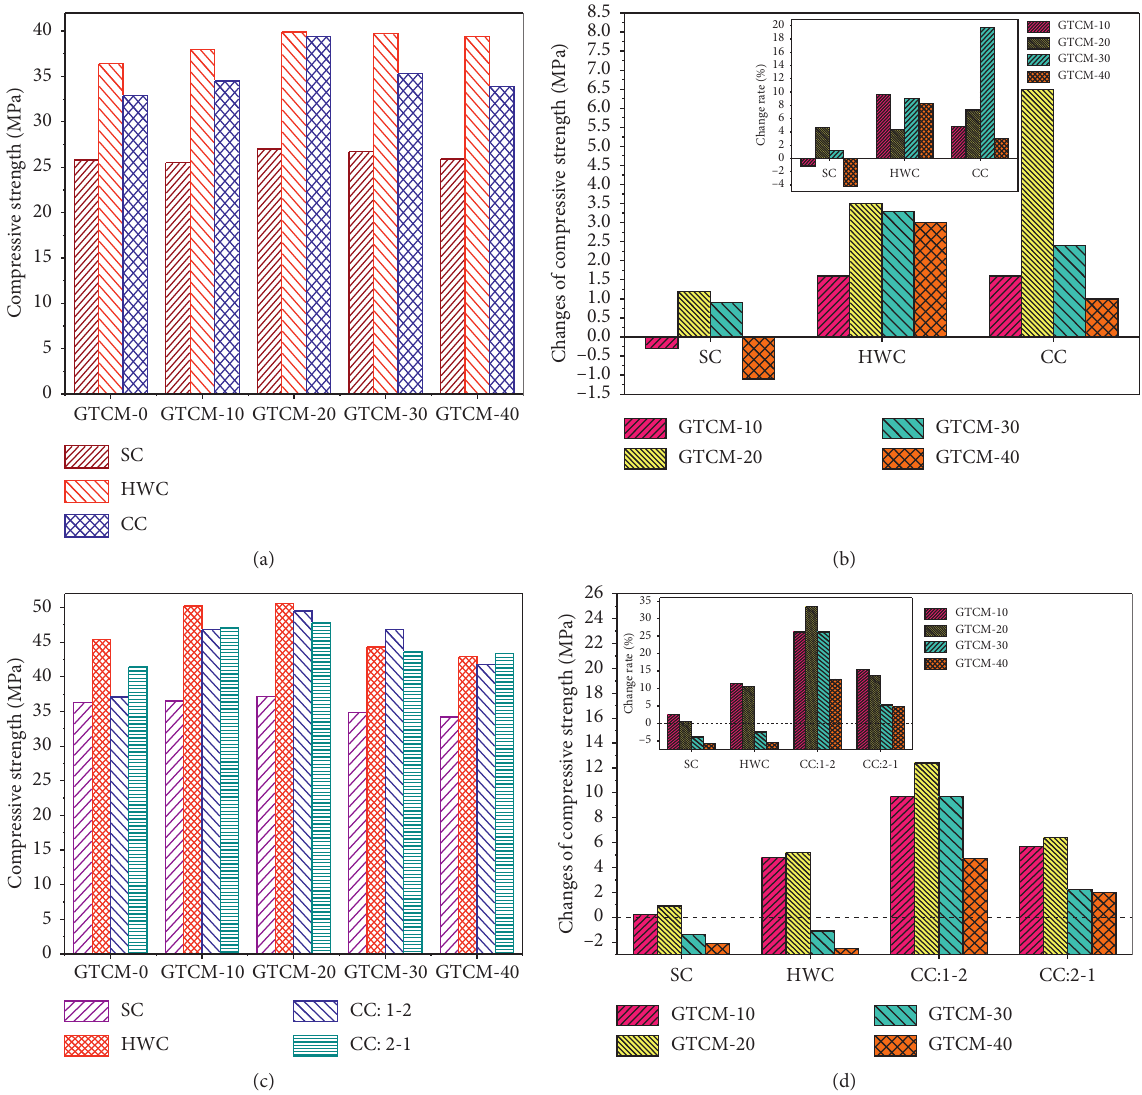
Figure 5: Compressive strength of GTCM under different cure methods: (a) 1 day; (b) changes of 1 day; (c) 3 days; (d) changes of 3